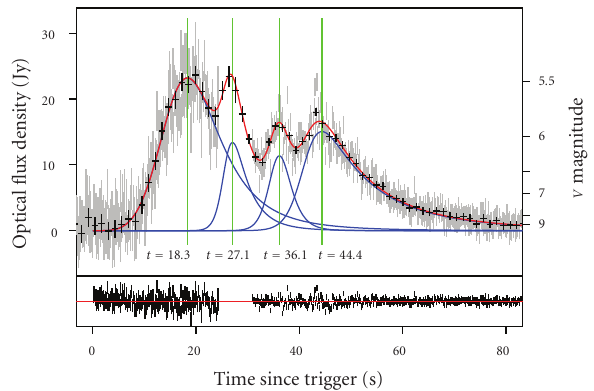
Figure 5: The light curve of GRB080319B acquired by TORTORA wide-field camera. The gamma-emission started at T ≈ − 4s and faded at T ≈ 55s. Full resolution (0.13s exposure, gray lines) data are available for all duration of gamma-emission except for interval of REM telescope repointing (24 . 5s < T < 31s), while low- resolution ones (summation of 10 consecutive frames, 1.3s e ff ective exposure)—for the whole time. The light curve is approximated by a four nearly equidistant flares; lower panel shows the residuals of such approximation.